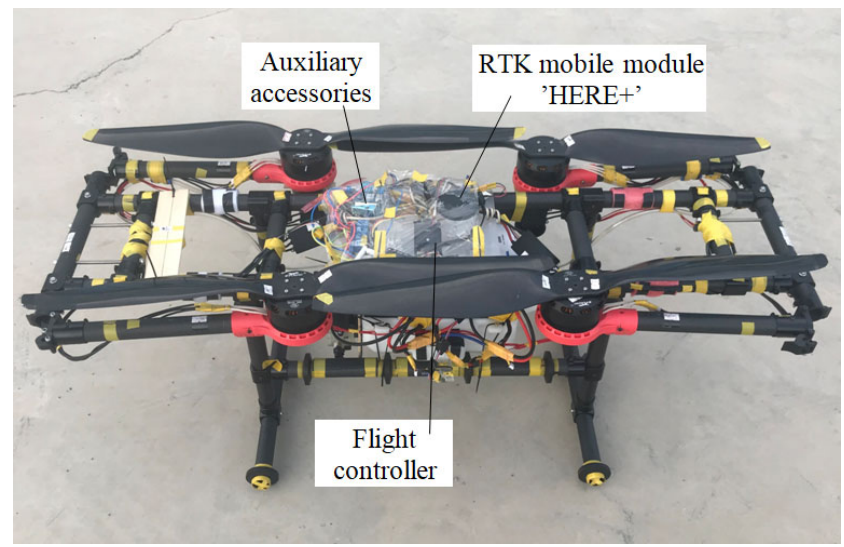
Figure 4. Four ‐ rotor UAV prototype. Figure 4. Four-rotor UAV